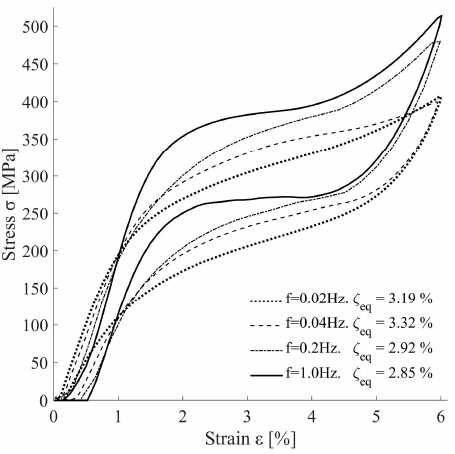
Figure 10. Hysteresis loops of specimens under quasi-static and dynamic loading at 6% strain.